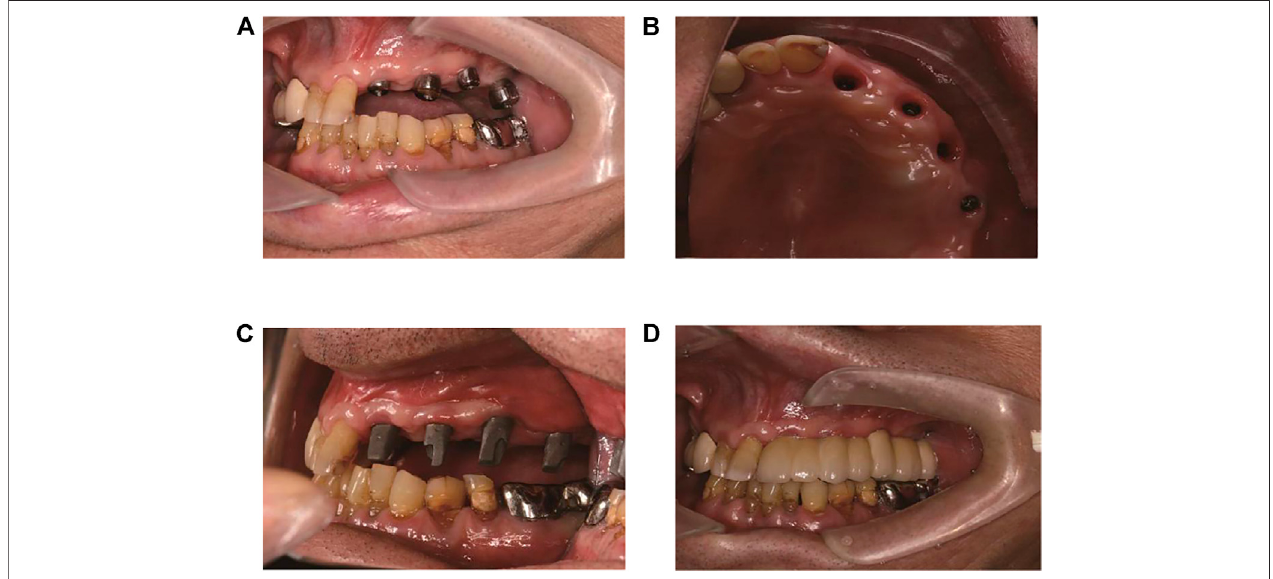
FIGURE 6 | The prosthodontics. (A) 6-month postoperative view. (B) Soft tissue cuffs appearance. (C) Custom-made abutments in place. (D) Application of the fi nal prosthetic denture.